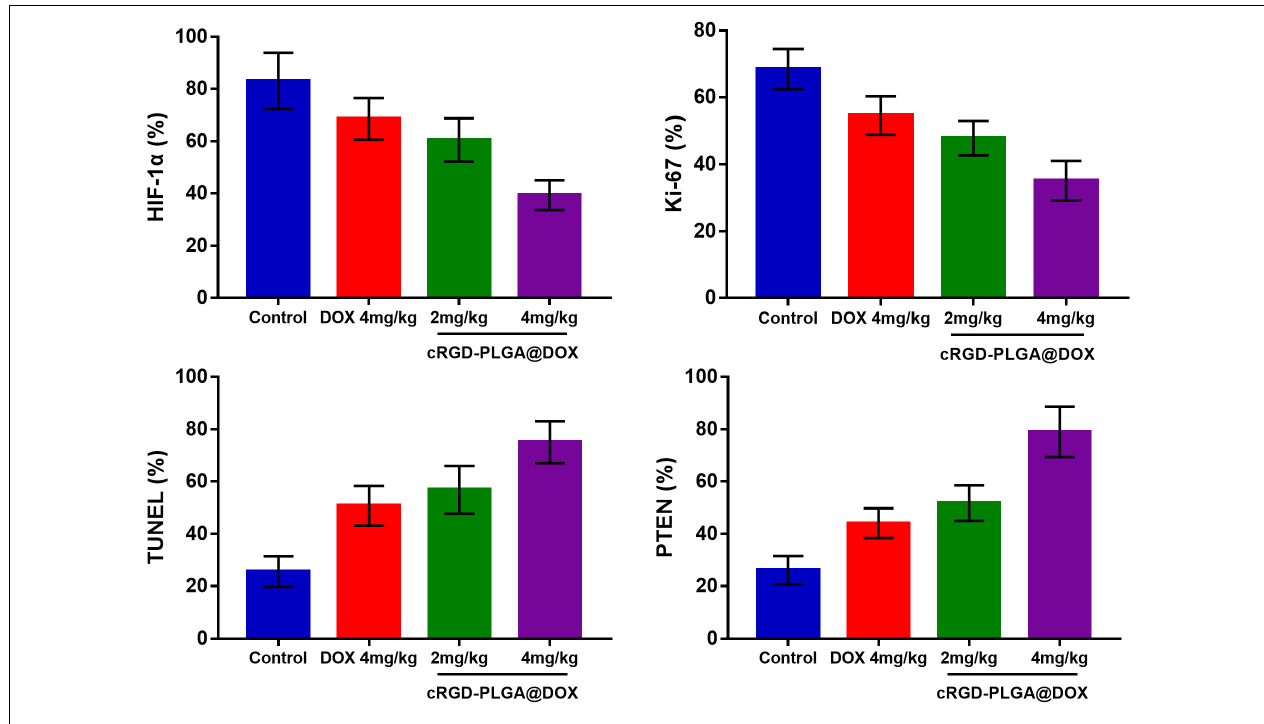
FIGURE 9 | The column charts of pathological indicators in the four groups. TABLE 4 | Pearson correlation coefficients between imaging and pathological